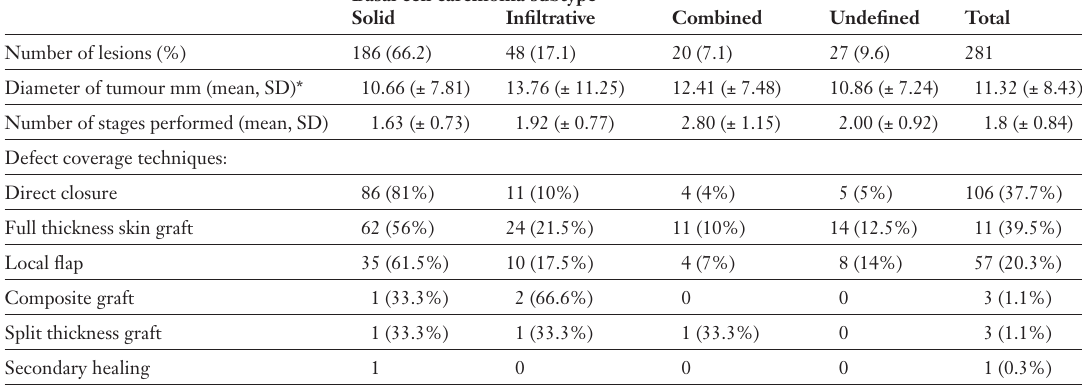
Histological findings and surgical defect coverage techniques applied in the staged surgical therapy of BCC in the face, head and neck